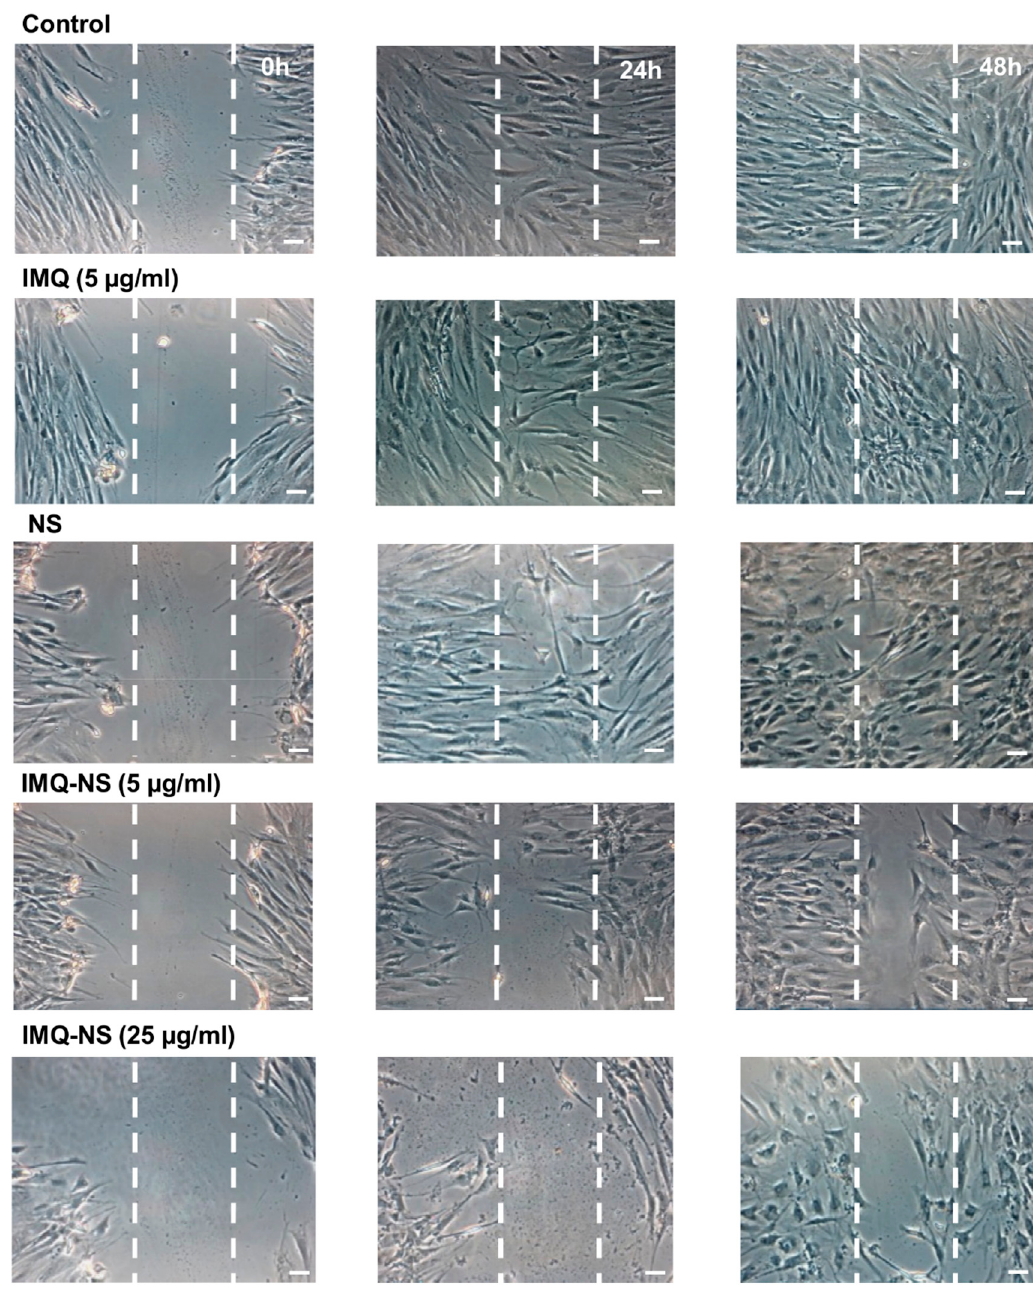
Figure 8. Inhibitory effect of IMQ–NS in a scratch wound assay. The figure shows micrographs of the extent of closure obtained under control conditions compared to those with free IMQ (5 µ g/mL), NS or IMQ–NS (5 and 25 µ g/mL) after 24- and 48-h treatment. The fibroblasts were synchronized for 2 h, wounded and treated as indicated, and phase-contrast microscopy pictures were taken of the wounded area (scale bar 100 µ m). One representative experiment out of three is shown.